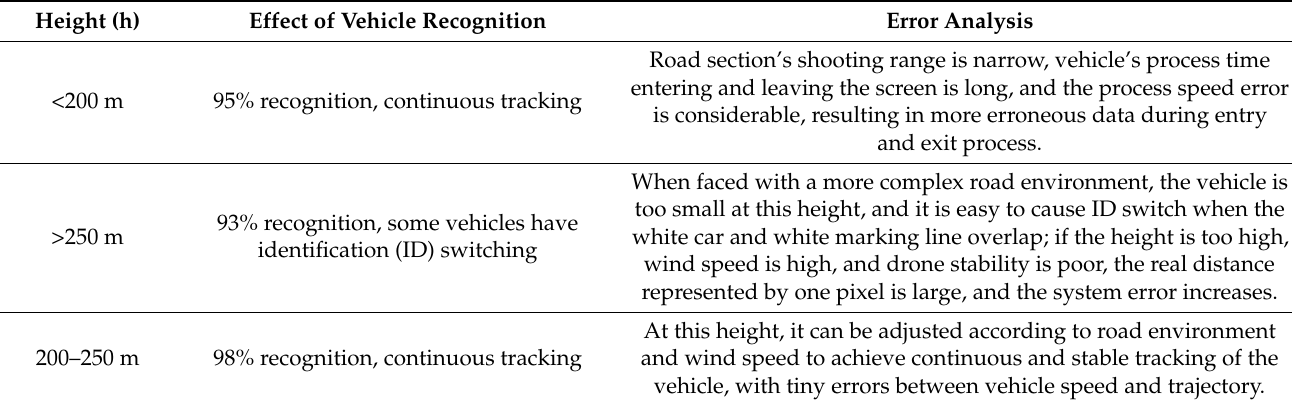
Table 3. Flight altitude